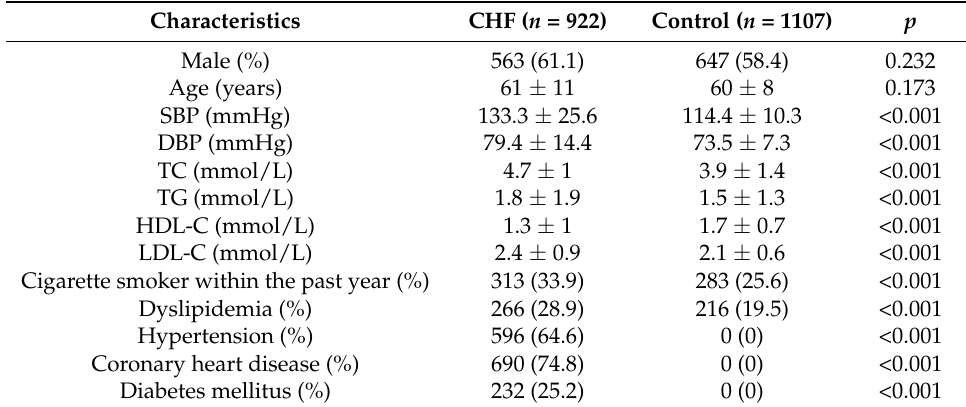
Table 1. Baseline characteristics of the study